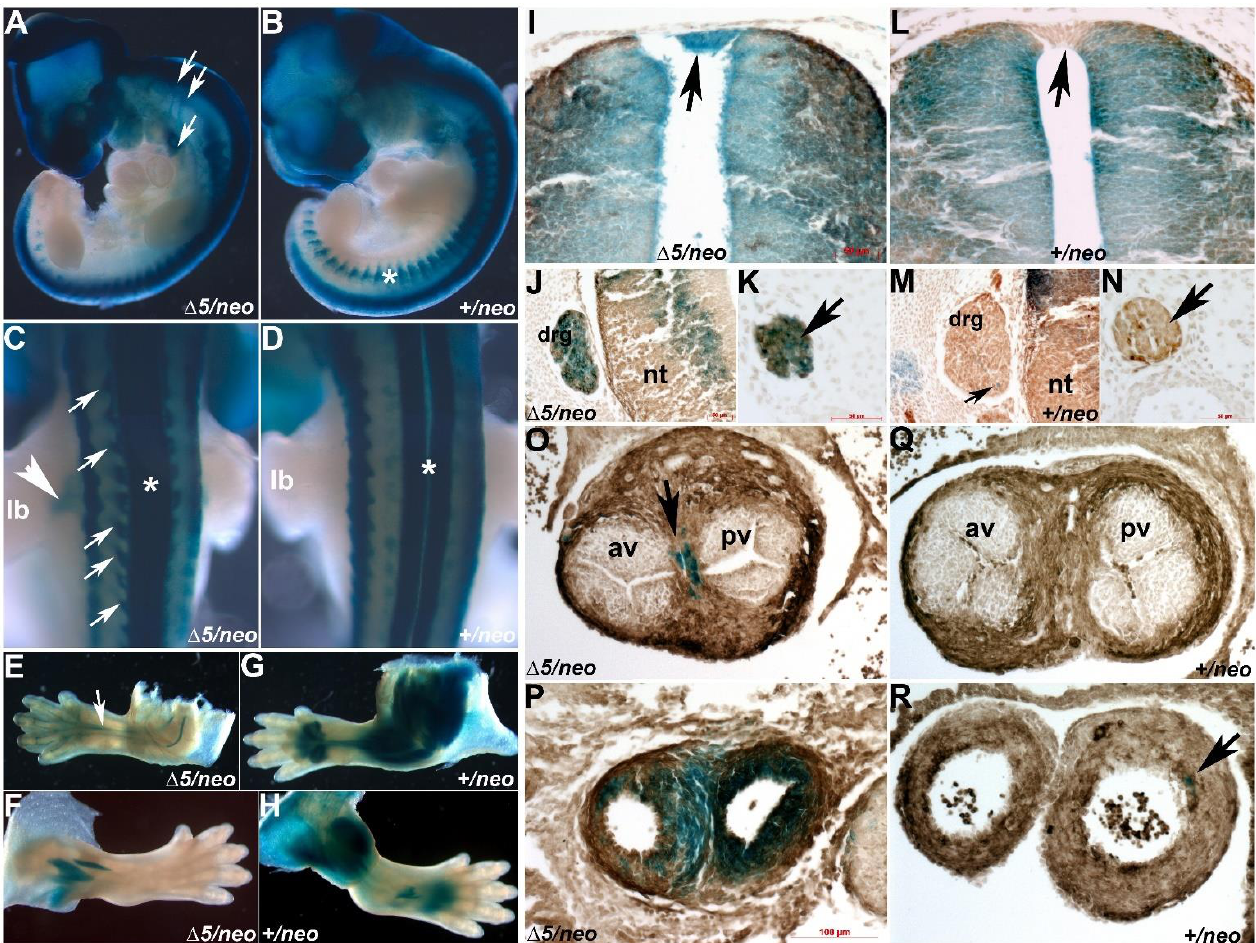
Figure 5. Pax7 Cre /R26r lineage mapping reveals ectopic Pax7-marked cells colonize Pax3 locations. ( A – D ) Left lateral ( A , B ) and dorsal ( C , D ) views of Pax3 ∆ 5/neo / Pax7 Cre /R26r LacZ ( A , C ) and control ( B , D ) X-Gal stained E11 embryos, illustrating enhanced and ectopic Pax7 -marked neural crest emigration towards the pharyngeal arches ( A , double arrows) and within the 4/6 th circumpharyngeal crest ( A , single arrow), when compared to control Pax3 +/neo littermate ( B ). Additionally, note reduced Pax7 Cre labeling of myocytes in mutant somites compared to control (* in B ). Dorsal view revealed Pax7 Cre - marked cells ectopically colonize the Pax3 ∆ 5/neo DRGs ( C , small arrows), the neural tube roofplate (* in C ) and PNS neural crest emigrating into mutant fore-limbs ( C , large arrow, lb) but not control limbs or roofplate (* in D ). ( E – H ) X-Gal staining of E15.5 Pax7 Cre -marked cells in in Pax3 ∆ 5/neo fore- and hind-limbs ( E , F ) compared to control limbs ( G , H ) which exhibit robust staining of muscle line- ages. Note ectopic Pax7 Cre positive labeling of PNS is obvious in only the Pax3 ∆ 5/neo mutant fore-limb ( E , arrow) due to severe hypoplastic musculature, whereas LacZ staining is absent in Pax3 ∆ 5/neo hind- limbs ( F ). ( I – N ) Histology and neuron- specific β3 Tubulin IHC (brown DAB -positive cells) con- firmed E11 ectopic lacZ labeling of Pax3 ∆ 5/neo dorsal most region of the neural tube roofplate ( I , L , arrow), the DRGs ( J ) and strong bilateral staining was evident in the developing sympathetic gan- glia ( K , arrow), when compared to control roofplate and DRG which do not contain lacZ cells (ar- rows in M , N ). Note while mutant DRGs are ~100% LacZ labeled, the control DRG only has a single lacZ cell in this section ( M , small arrow). ( O – R ) Transverse sections through αSmooth muscle actin IHC (brown DAB-positive cells) in outflow tract regions in Pax3 ∆ 5/neo mutant ( O , P ) and Pax3 +/neo con- trol ( Q , R ) hearts. Significant ectopic LacZ cells are present in both the Pax3 ∆ 5/neo valve (small arrow in O ) and more anterior outflow tract vessel ( P ) planes. Note robust Pax7 Cre -marked populations colonize Pax3 ∆ 5/neo outflow tract septum between the aortic (av) and pulmonary (pv) valves, as well as the smooth muscle of the great arteries, but a few isolated LacZ cells were found in more anterior planes in controls ( R , arrow). Scale ( I – N ), 50 μm; ( O – R ), 100 μm .